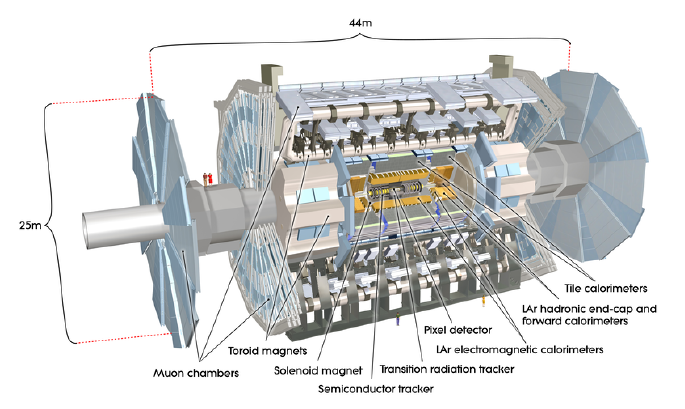
Figure 1. ATLAS detector, the figure shows placement of TileCal within the detector. The TileCal is shown in gray